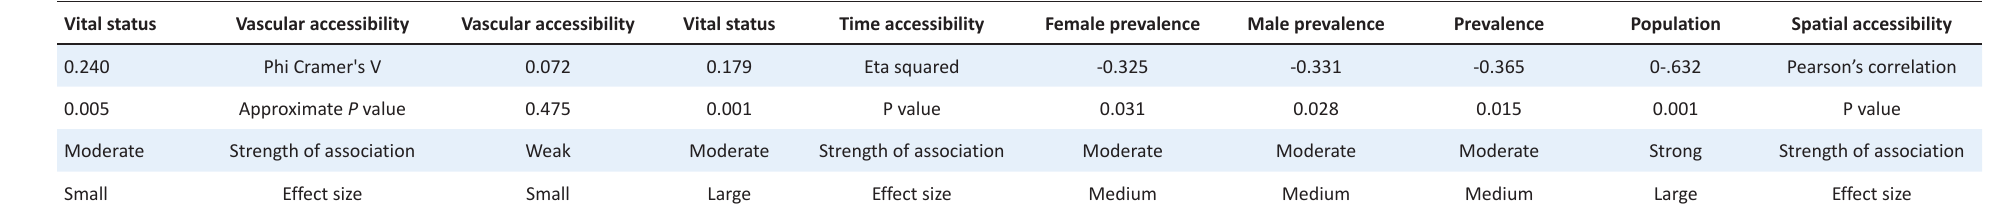
Table 2. Correlation and its severity and effect size between variables of accessibility and prevalence, vascular accessibility and vital